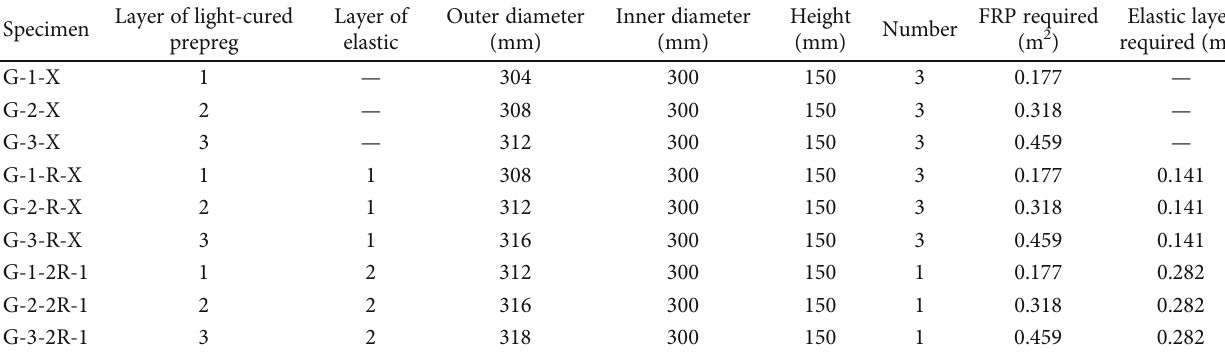
Table 1: Details of specimen.